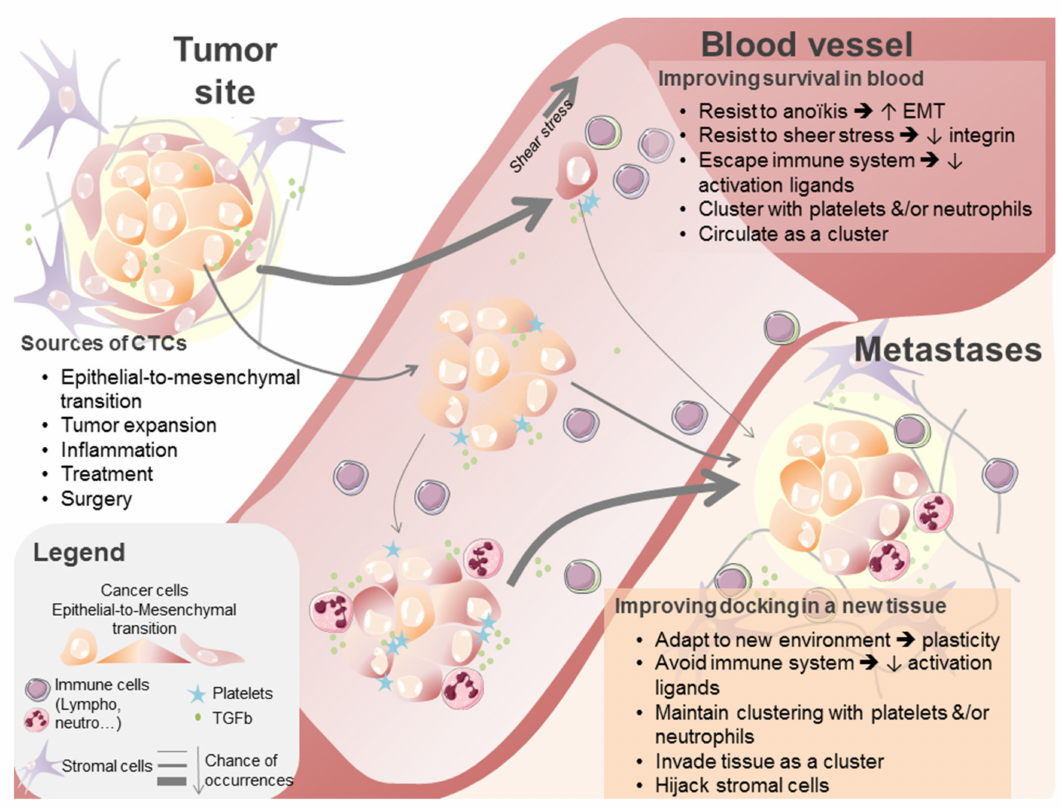
Figure 2. Description of circulating tumor cell (CTC) origins, biological features required to survive blood stream pressures, and abilities facilitating metastases